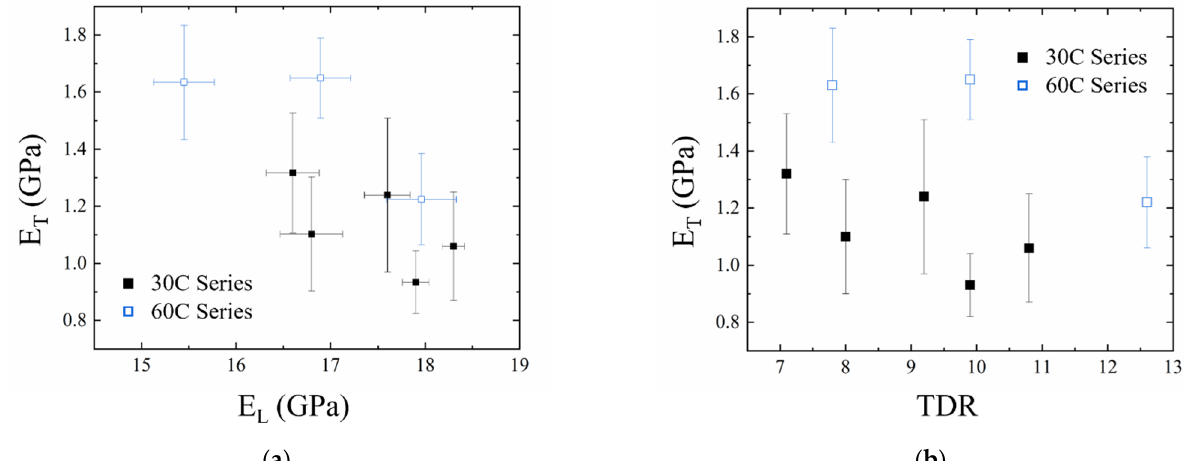
Figure 5. Plots showing the dependence of E T on ( a ) E L and ( b ) TDR for the WFs measured in this study. The error bars represent the standard deviation.